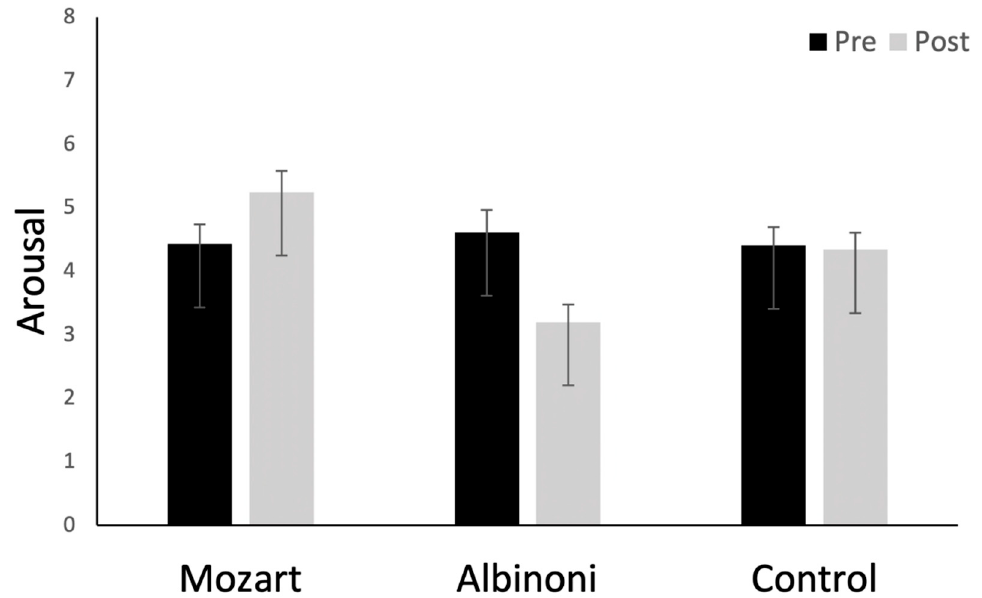
Figure 3. Means at pre- and post-test for arousal scores. Higher scores correspond to higher levels of arousal. Error bars are SE s. The figure illustrates the two-way interaction between test session and listening condition: arousal increased in the Mozart condition, decreased in the Albinoni condition, and remained unchanged in the control condition.